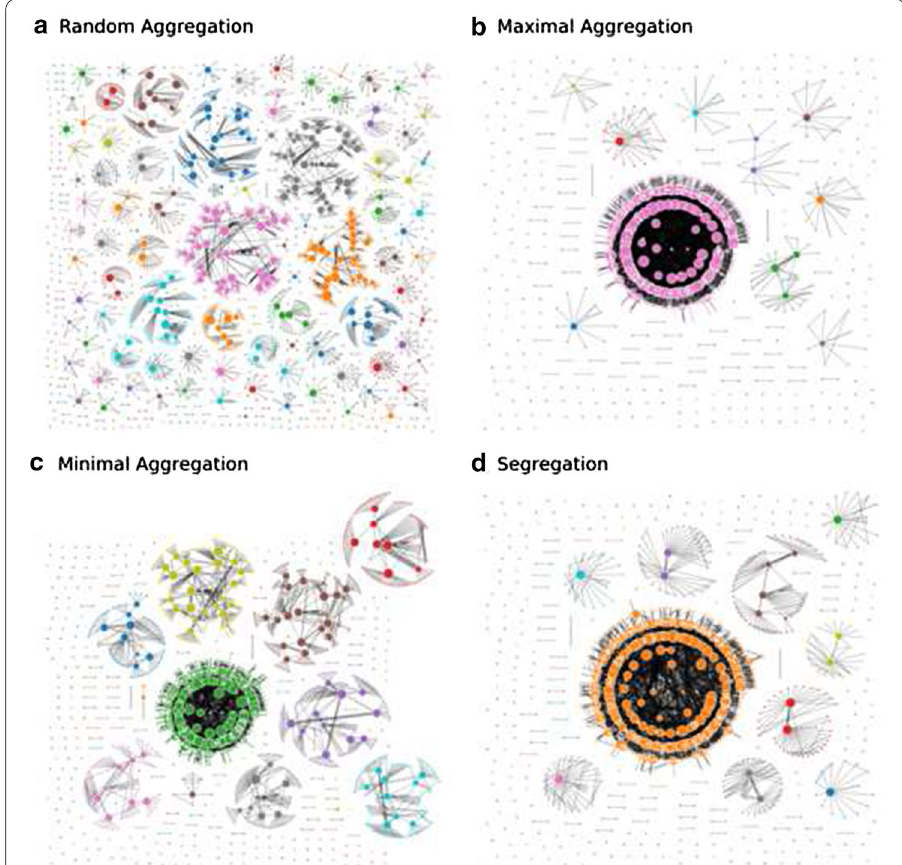
the number of people working in that workplace. If the workers of two workplaces are part of the same household, the workplaces are connected by a link. The link width is proportional to the number of common housemates. The smallest dots represent people who work from home or do not work (workplace of size 1). The nodes are colored according to the strategy (different for each panel from a – d ). The number of colors chosen is N c =